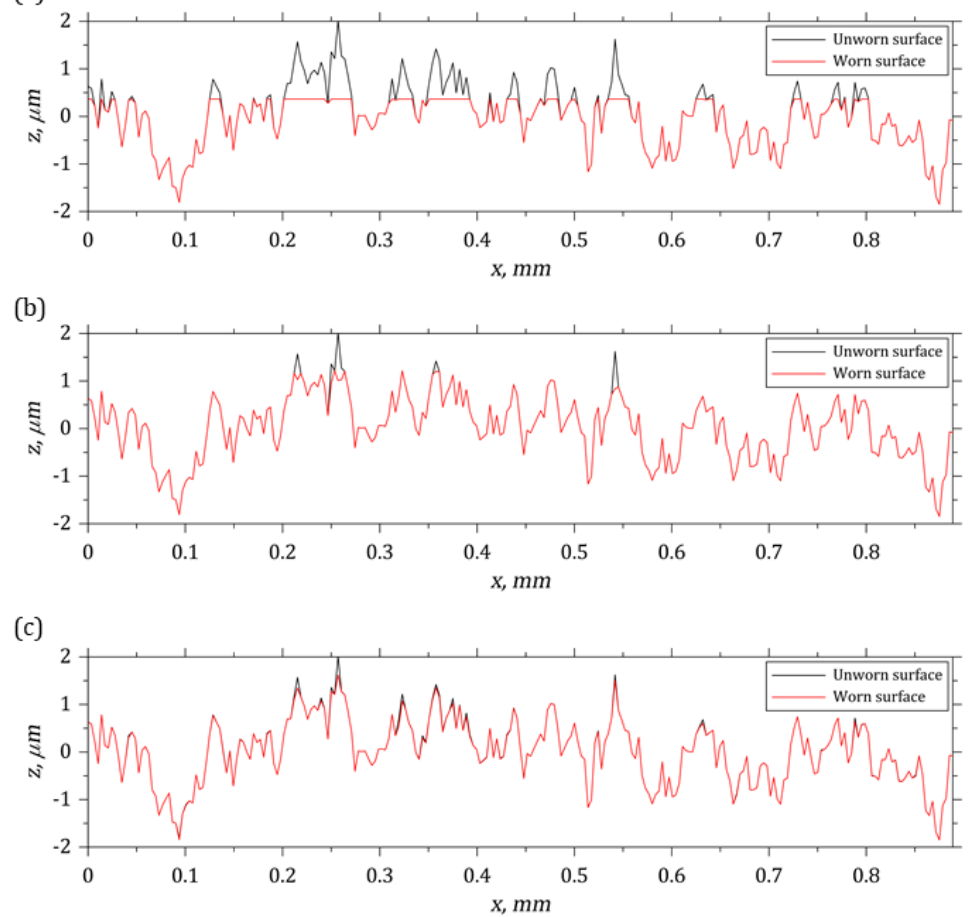
Figure 5. 2D profile of unworn and worn surface: ( a ) Truncation model; ( b ) deterministic fixed model; ( c ) deterministic quasi-static model.